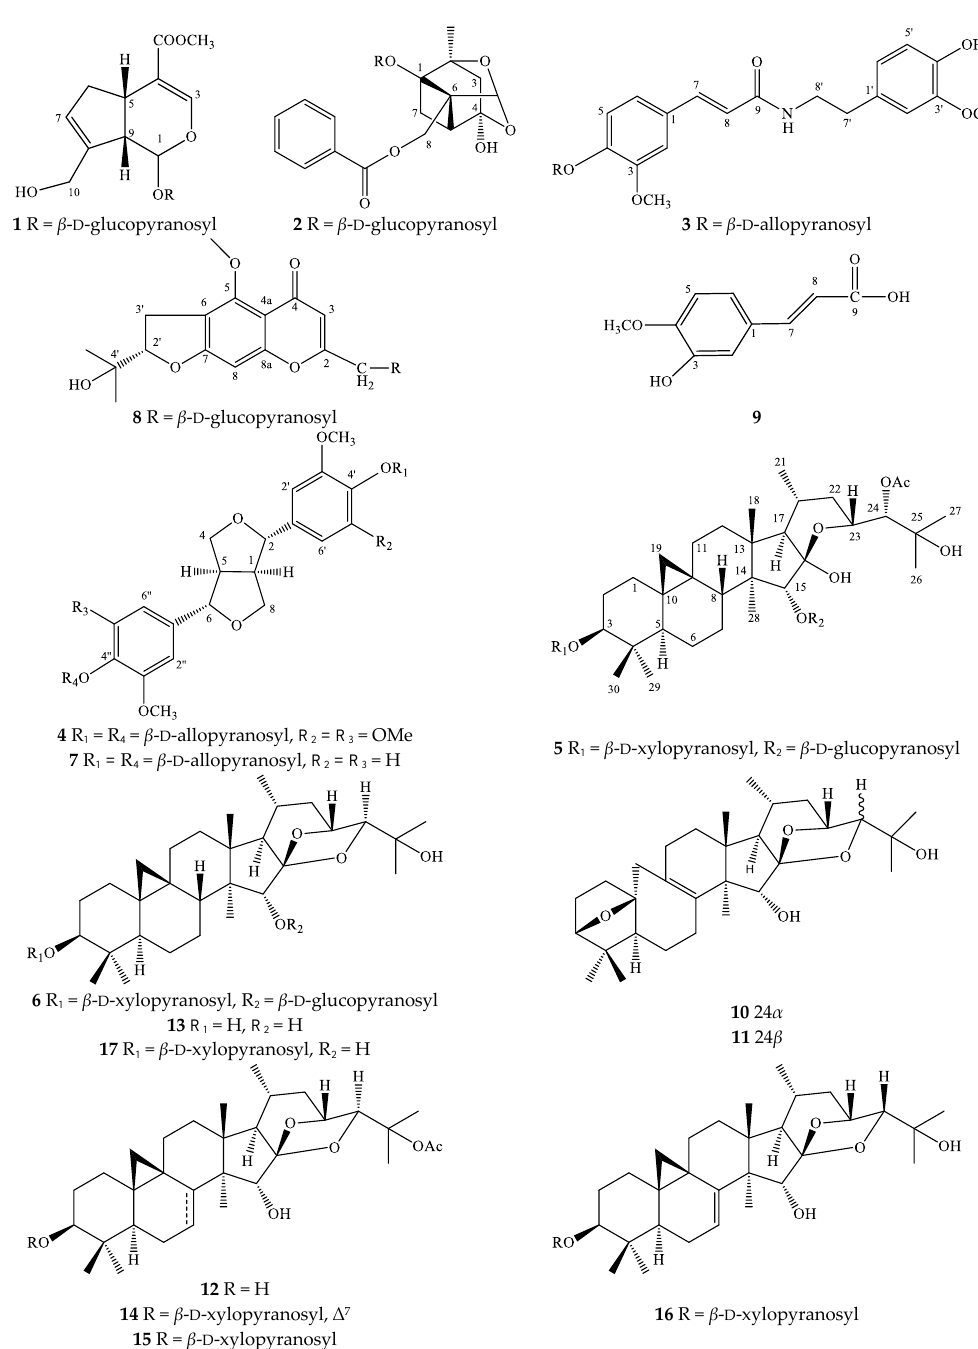
Figure 1. Structures of compounds 1 – 17 isolated from C. dahurica .